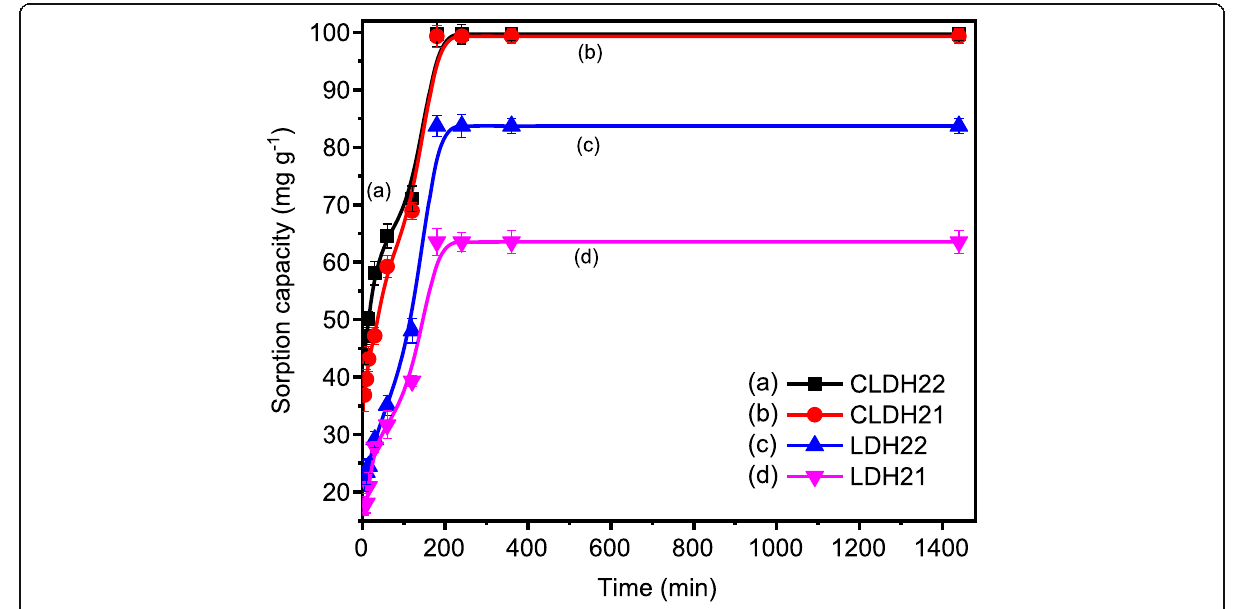
Fig. 5 Effect of shaking time on adsorption capacity of IDB onto LDHs and CLDHs adsorbent, C i = 100 mg L −